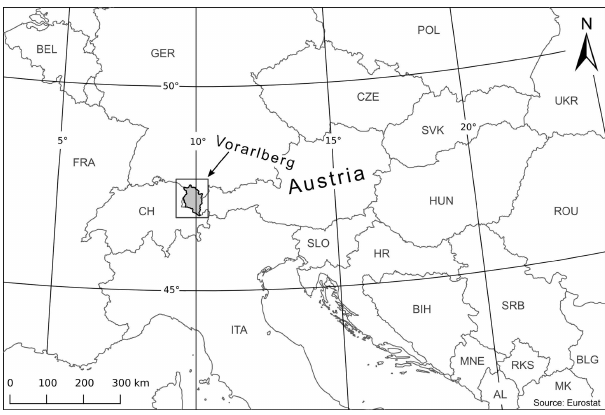
Figure 1. Location of the study area in